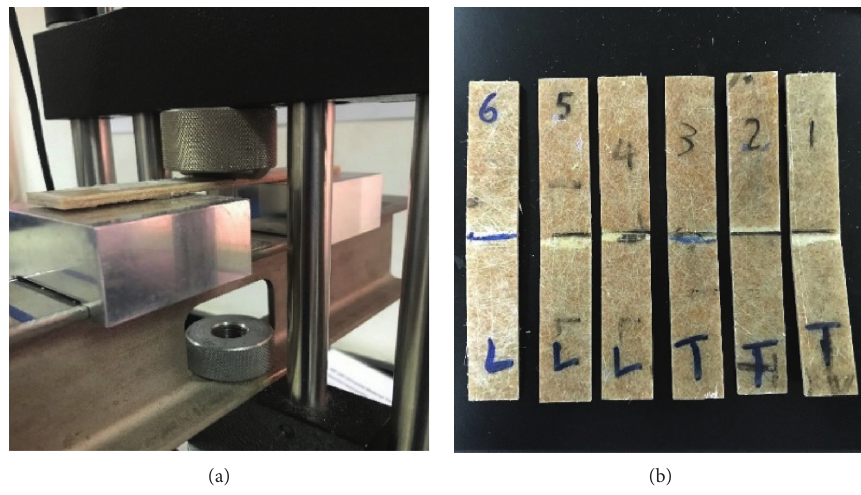
Figure 8: (a, b) Flexural specimens before and after testing.